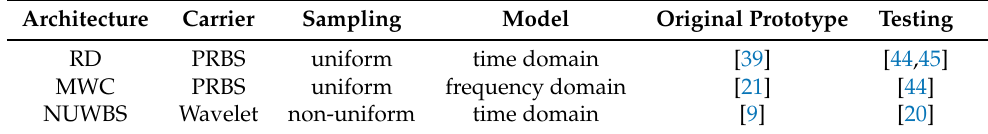
Table 2. AIC architectures: working principle, original prototype and testing.